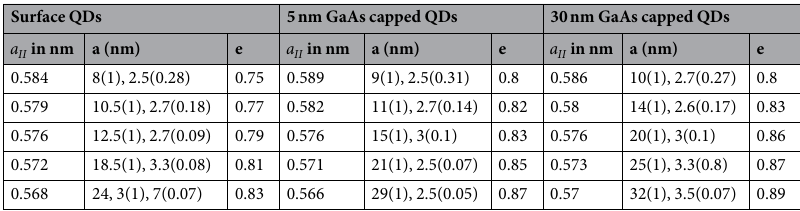
Surface QDs 5 nm GaAs capped QDs 30 nm GaAs capped QDs